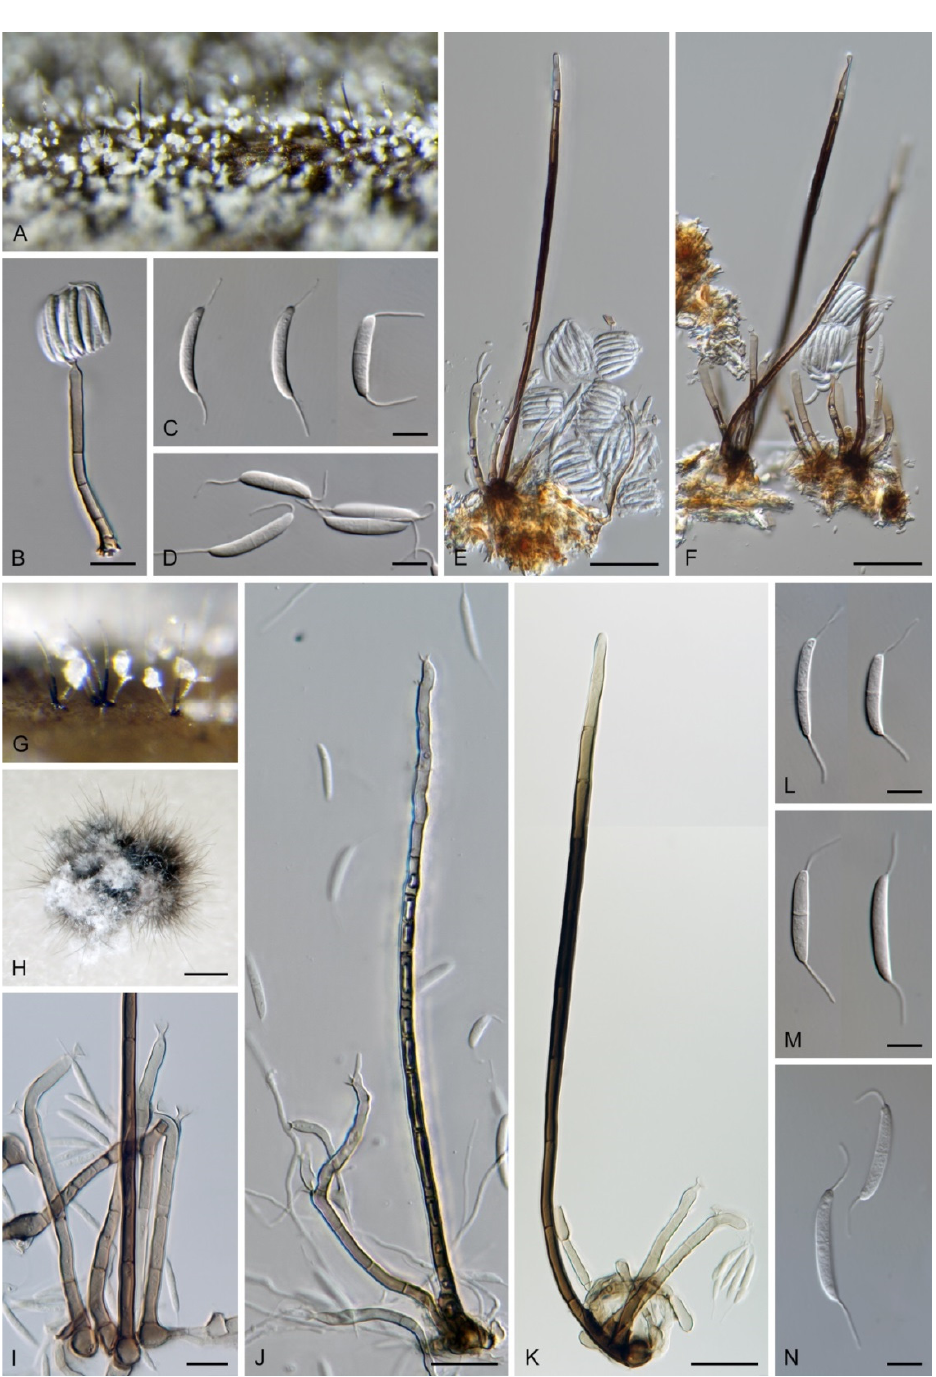
Figure 39. Stilbochaeta novae-guineensis . ( A , G ) Colonies ( B , I ) conidiophores ( C , D , L – N ) conidia ( E , F , J , K ) setae with conidiophores ( H ) setae and conidiophores arranged in a sporodochium-like. Images: ( A – F ) from nature ( G , J , L – N ) on a stem of U. dioica on CMA after 4 weeks ( H , I , K ) on OA after 8 weeks ( A , G , J , L – N ) from CBS 147515 ( H , I , K ) from CBS 147517. Scale bars: ( B , I ) 10 μ m; ( C , D , L – N ) 5 μ m; ( E , F ) 25 μ m; ( H ) 500 μ m; ( J , K ) 20 μ m.